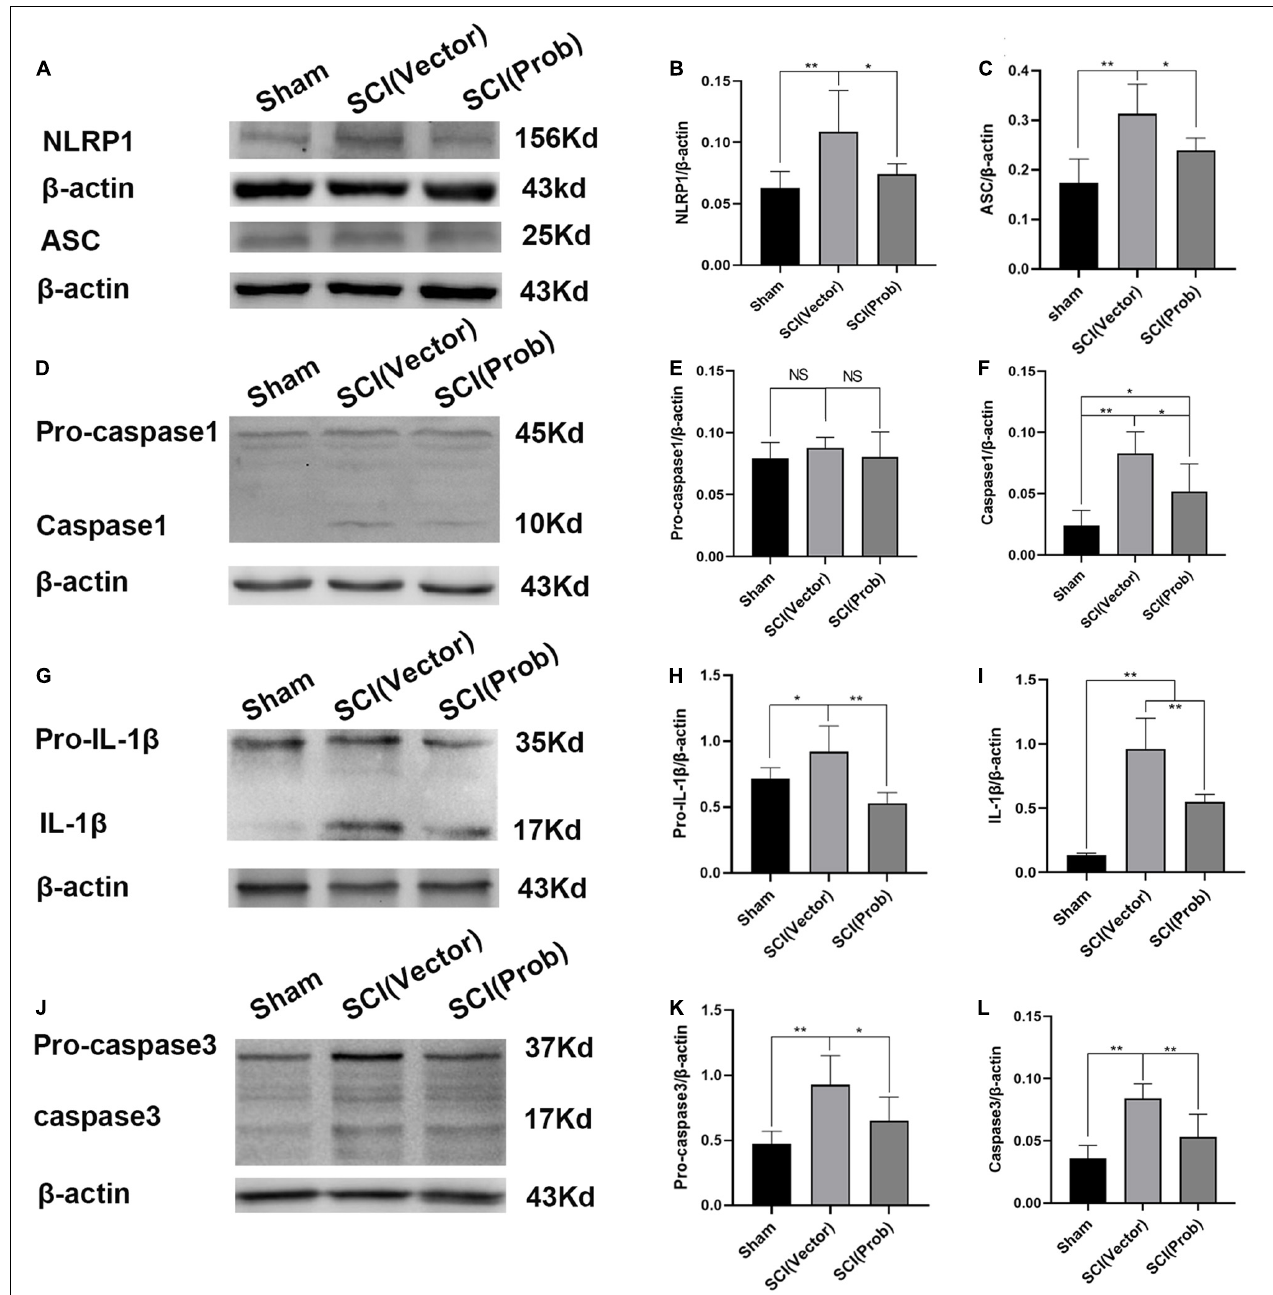
FIGURE 1 | Probenecid inhibits the expression of inflammasome-associated molecules at 3 days following spinal cord injury (SCI). (A,D,G,J) Representative pictures of WB results of the expression of NLRP1 and ASC (A) , pro-caspase-1and caspase-1 (D) , pro-interleukin-1 β (pro-IL-1 β ) and IL-1 β (G) , pro-caspase-3 and caspase-3 (J) . (B,C,E,F,H,I,K,L) Quantitative results of the expression of inflammasome-associated molecules (* p < 0.05, ** p < 0.01 n =